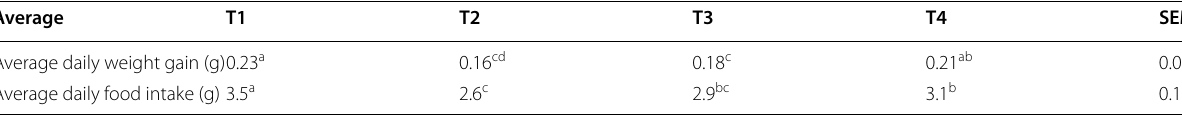
T1: normal diet. T2: normal diet